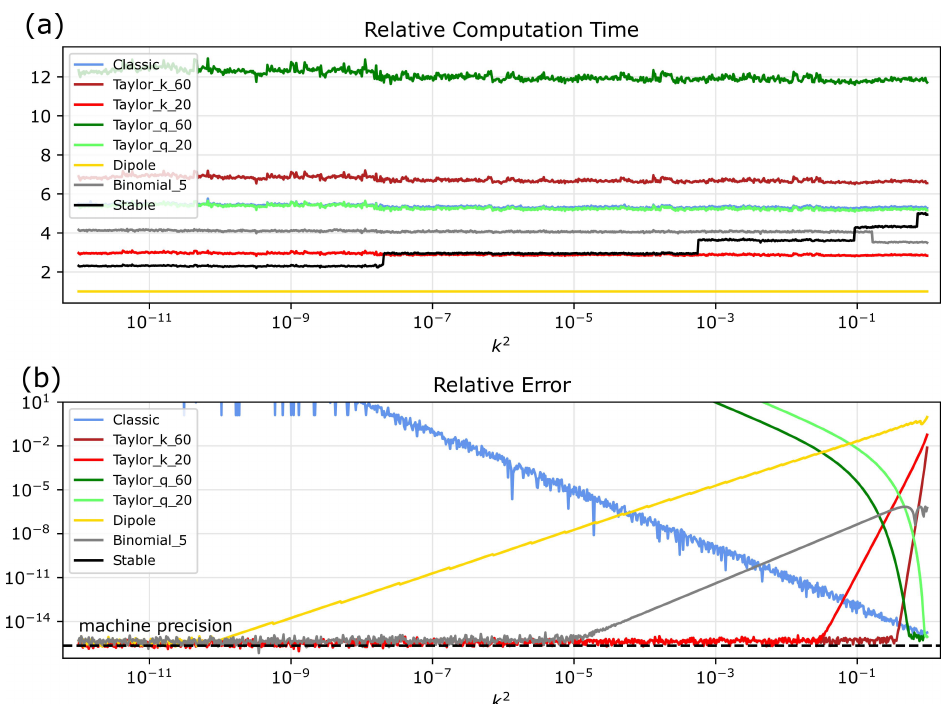
Figure 8. ( a ) Computation times of various methods with respect to the fastest one (dipole) as a function of k 2 . ( b ) The respective vectorwise relative